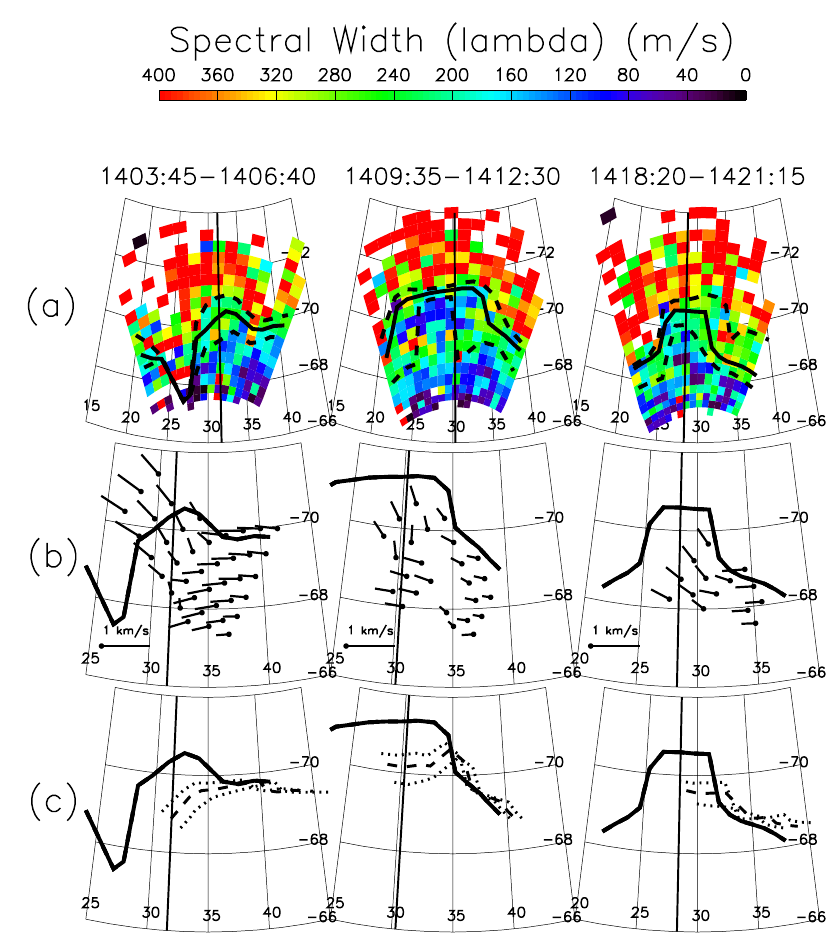
Fig. 5. Data from three Halley radar scans during the interval 13:50–15:00UT (times shown). ( a ) The spectral width variation. The bold and dashed lines represent the spectral width boundary (see text). ( b ) Comparison of merged velocity vectors and the spectral width boundary. ( c ) Comparison of the spectral width boundary (bold line) with the mapped estimates of the polar cap boundary (dashed and dotted lines, see